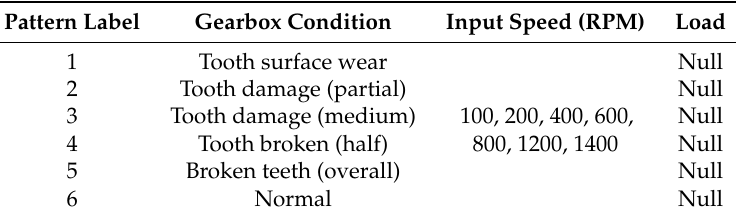
Figure 8. Faults of the planet reducer (zoom × 50). Table 1. Pattern labels and test conditions of the gear